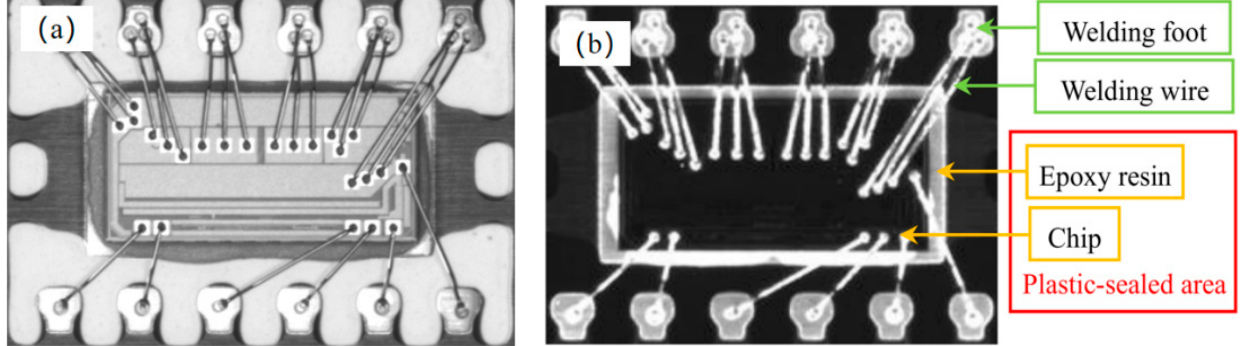
Figure 1. Image of chip. ( a ) Plastic package side; ( b ) pin side.